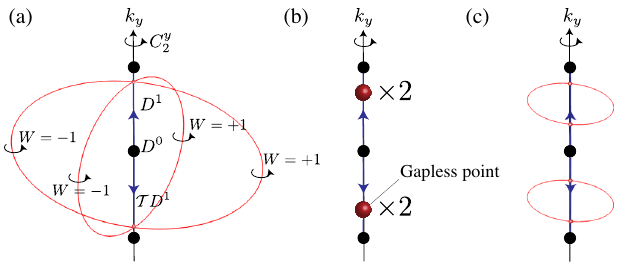
FIG. 14. Deformation of nodal structures in MSG P 21 0 . Two line nodes pinned to the rotation axis are protected by 1D winding numbers (a). These line nodes can be deformed to point nodes without a closing gap at 0-cells (b). Since there are no reasons why two point nodes are at the same position, each of the two split gapless points is again part of a line node.